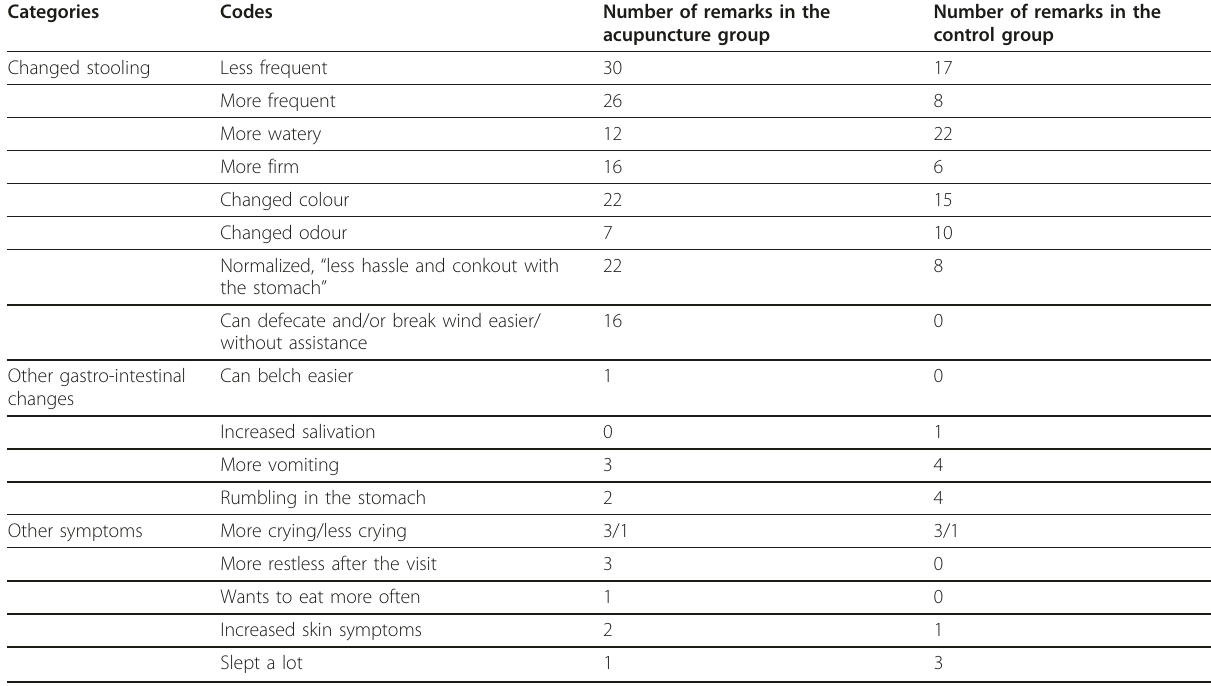
Table 3 Changes in stooling pattern and possible side effects of intervention as described by the parents in a questionnaire from the second till the sixth visit at the